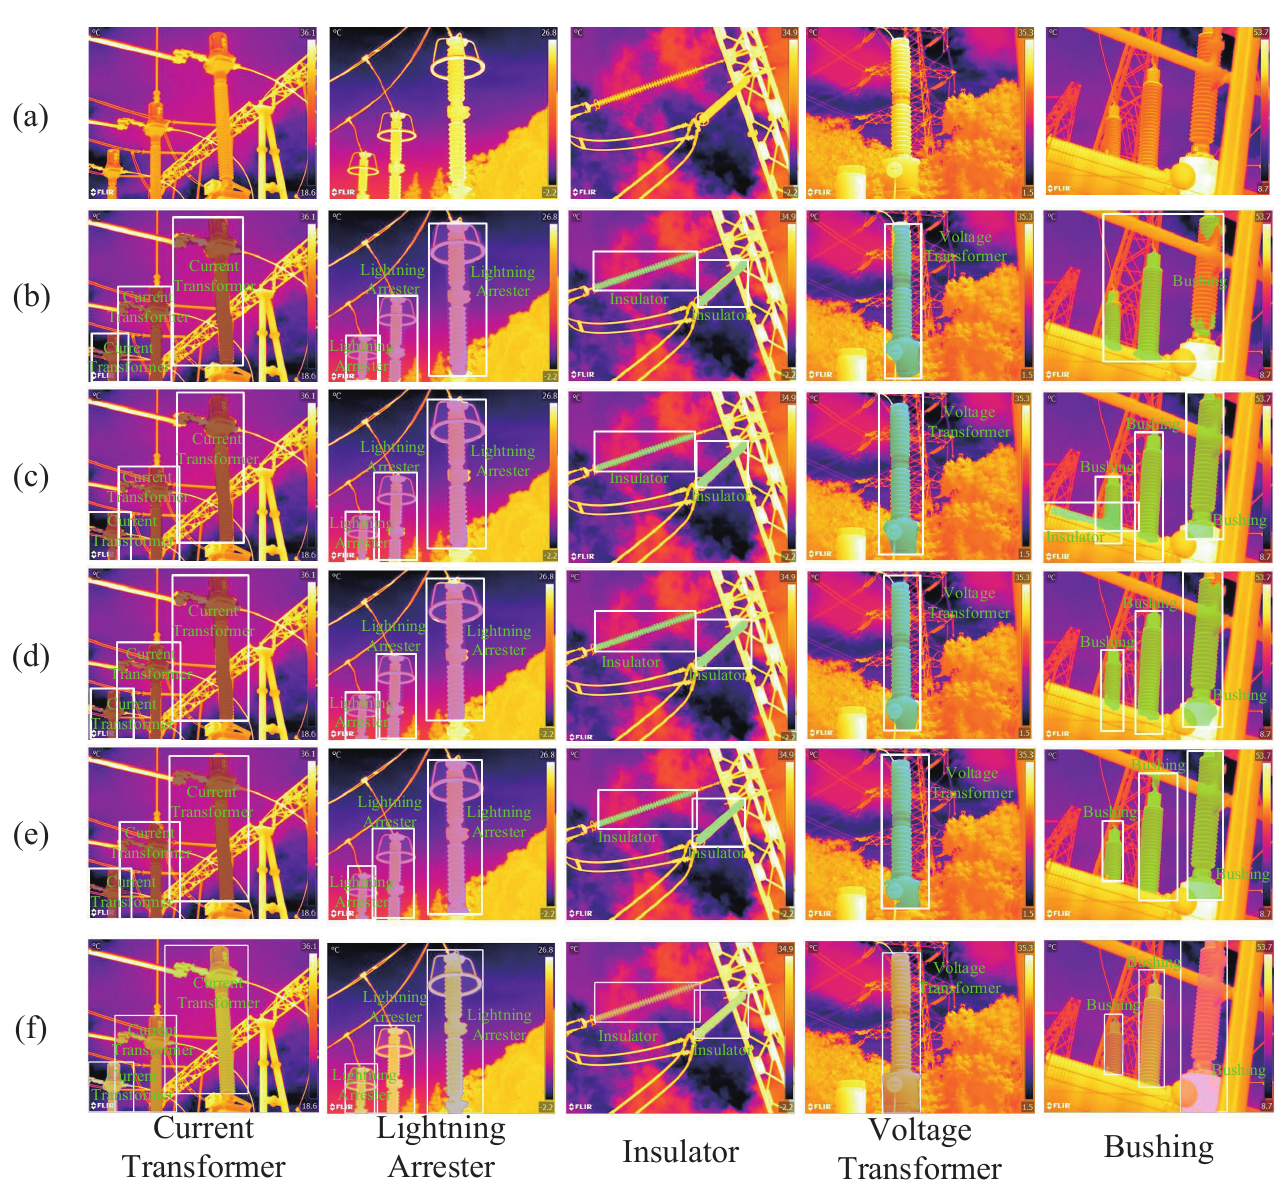
Figure 5. Comparison of segmentation results of different instance segmentation algorithms. ( a ) Orig- inal Images. ( b ) SOLO. ( c ) Mask R-CNN. ( d ) Mask Scoring R-CNN. ( e ) YOLACT. ( f ) Ground